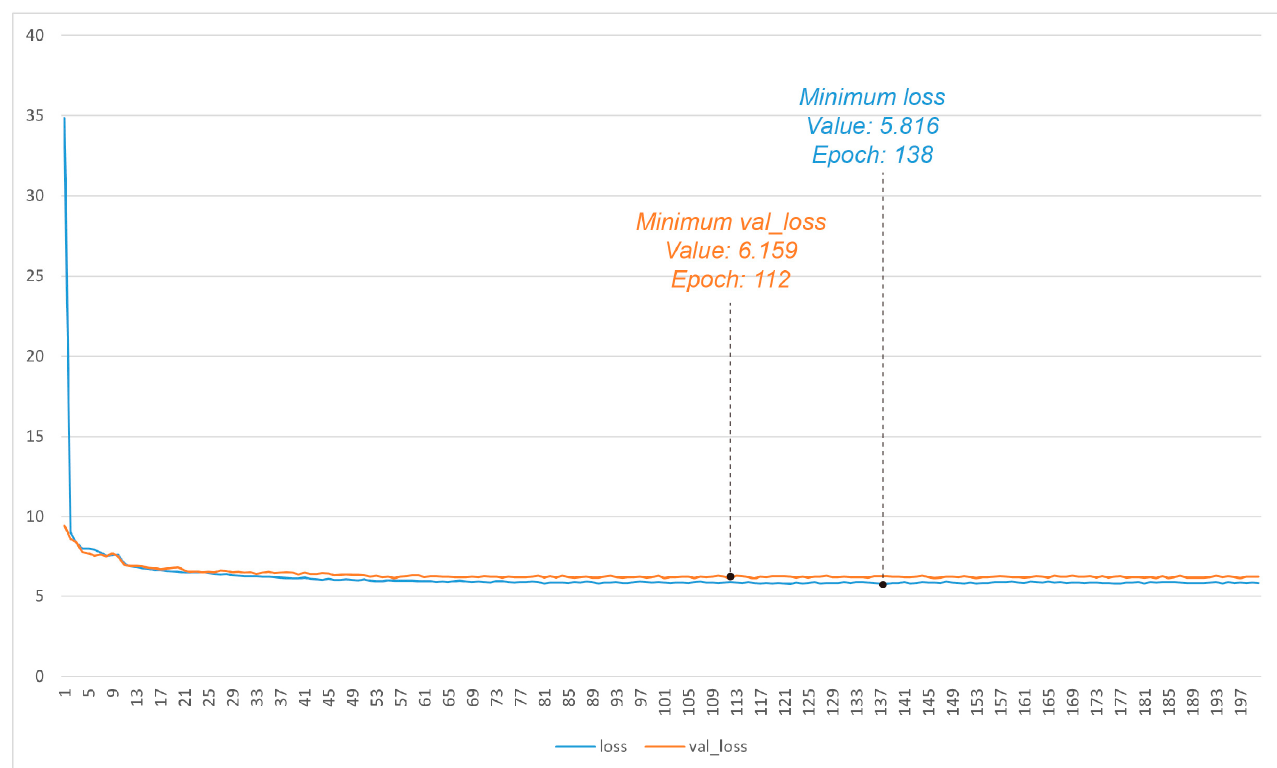
Figure 8. The trend of LOSS value during model training. (Image Source: drawn by the author).